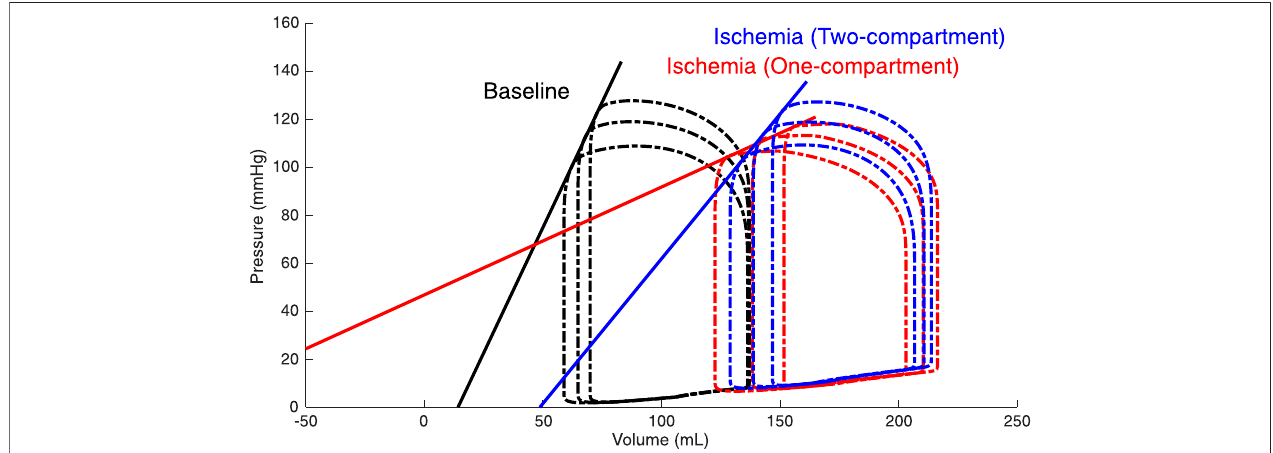
FIGURE 3 | Simulated left ventricular (LV) end-systolic pressure-volume relations (ESPVRs) for a baseline healthy LV (black loops and line) and for an ischemic LV affecting20%ofthe LVwallmassmodeled bya two-compartment approach (blueloops and line) and aone-compartmentapproach(red loopsand line). ESPVRs were constructed by afterload manipulations through reducing and increasing arterial resistance by 20% compared to the reference resistance. The two-compartment simulationofischemiademonstratedarightwardshiftoftheESPVRwithamoderatereductionintheslope,whiletheone-compartmentsimulationdemonstrateda severe reduction in both the slope and zero-pressure volume.